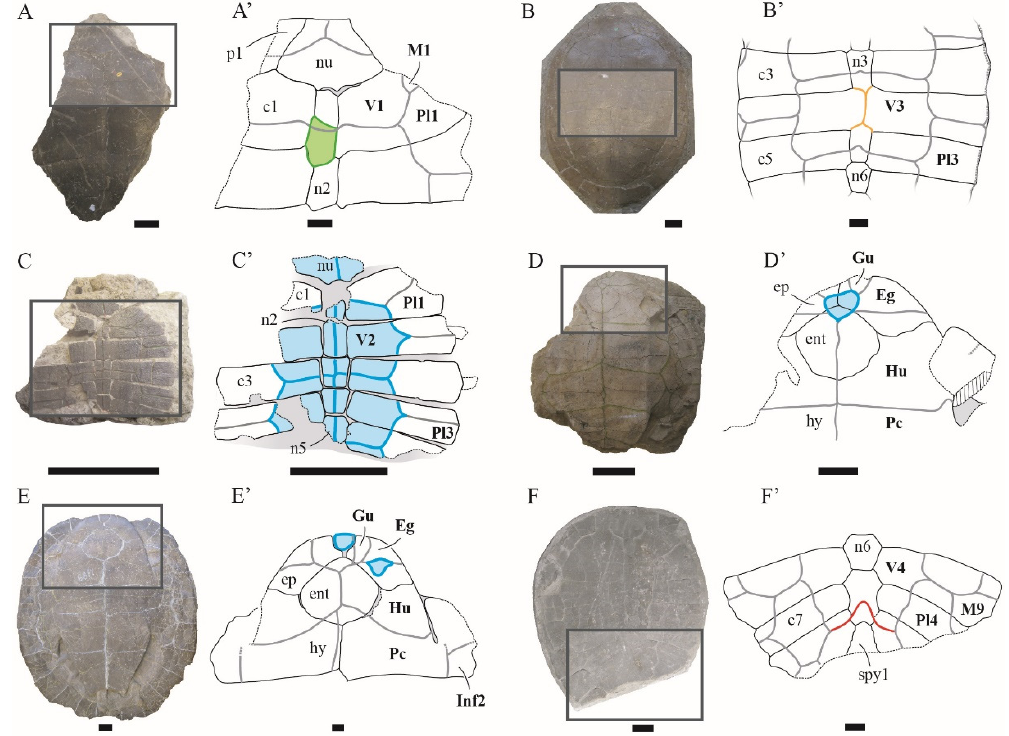
Figure 2. Anomalous shells of Pleurosternon bullockii (Paracryptodira, Pleurosternidae). All specimens are from the Berriasian (Early Cretaceous) of Swanage (Dorset, England), except NHMUK OR 44807, which is from the Tithonian (Late Jurassic) of the Isle of Portland (Dorset). ( A , A’ ) NHMUK 24298 in dorsal view, ( B , B’ ) NHMUK OR 28618 in dorsal view, ( C , C’ ) NHMUK 48263c in dorsal view, ( D , D’ ) NHMUK OR 44807 in ventral view, ( E , E’ ) NHMUK R 1889 in ventral view, and ( F , F’ ) DORCM G6262 in dorsal view. Blue corresponds to additional elements, green corresponds to the unusual shape of the plates, red corresponds to the unusual shape of the scutes, and orange corresponds to the absence of regular shell plates. Abbreviations for the plates (in lowercase and normal type): c, costal; ent, entoplastron; ep, epiplastron; hy, hyoplastron; n, neural; nu, nuchal; p, peripheral; and spy, suprapygal. Abbreviations for the scutes (in uppercase and in bold type): Eg, extragular; Gu, gular; Hu, humeral; Inf, inframarginal; M, marginal; Pc, pectoral; Pl, pleural; and V, vertebral. The scale bars in the photographs equal 4 cm, and those in the drawings equal 2 cm.